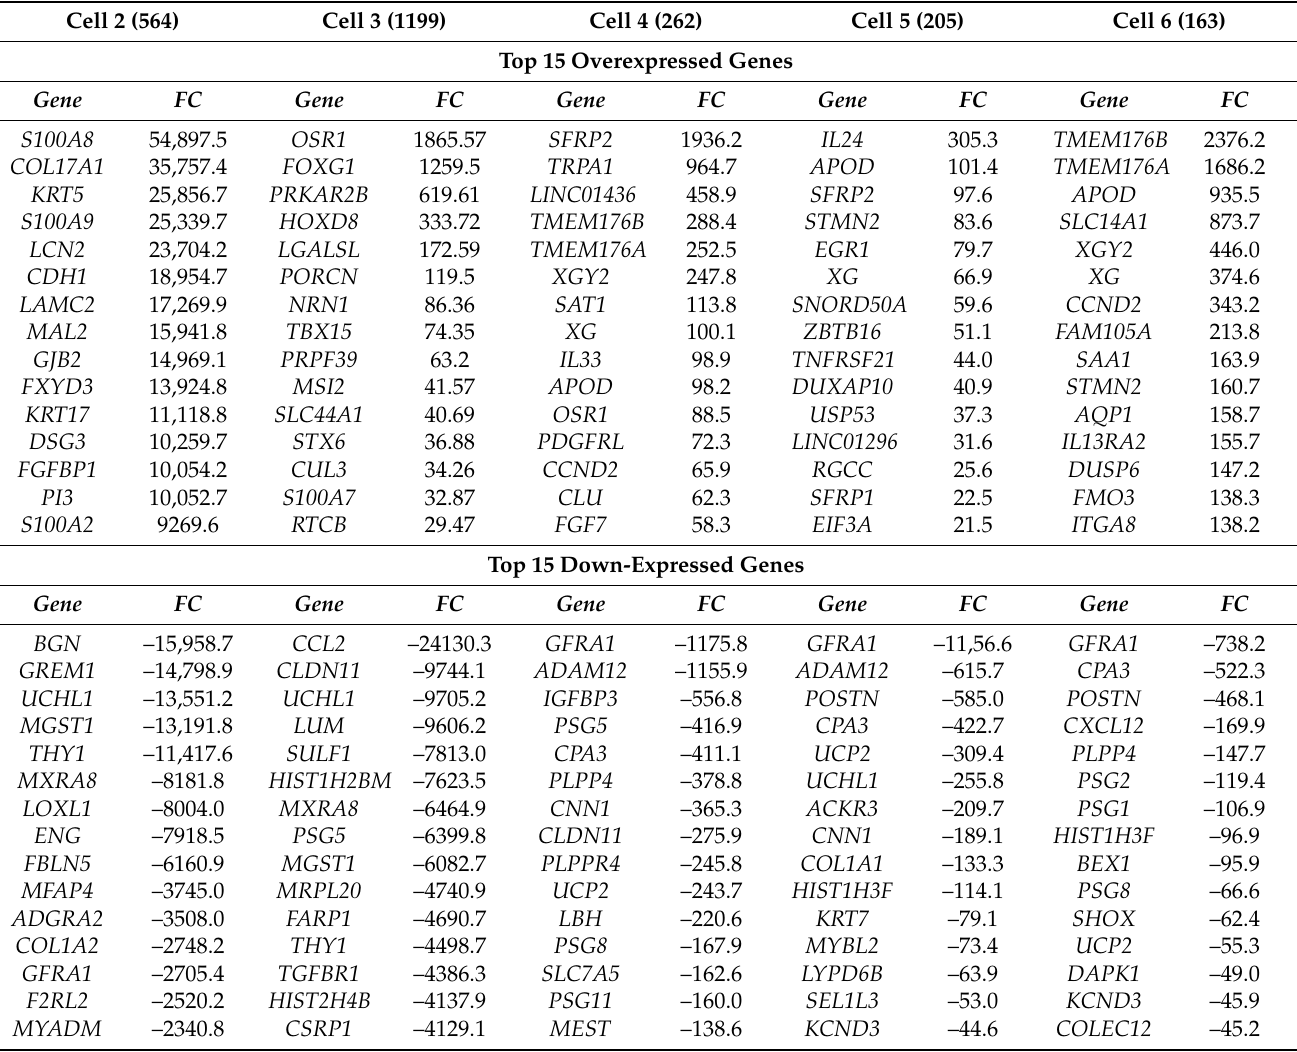
Table 3. Top 15 differentially expressed genes in penile cancer cells compared with the normal reference cell (cell 1). Translatomic profiling was performed using the microarray platform Clariom™ D Assay platform (Thermo Fisher Scientific, Waltham, MA, USA) after polysomal mRNA enrichment. The number within brackets represents differentially expressed genes after enrichment analysis, indicating genes more likely to be translated into